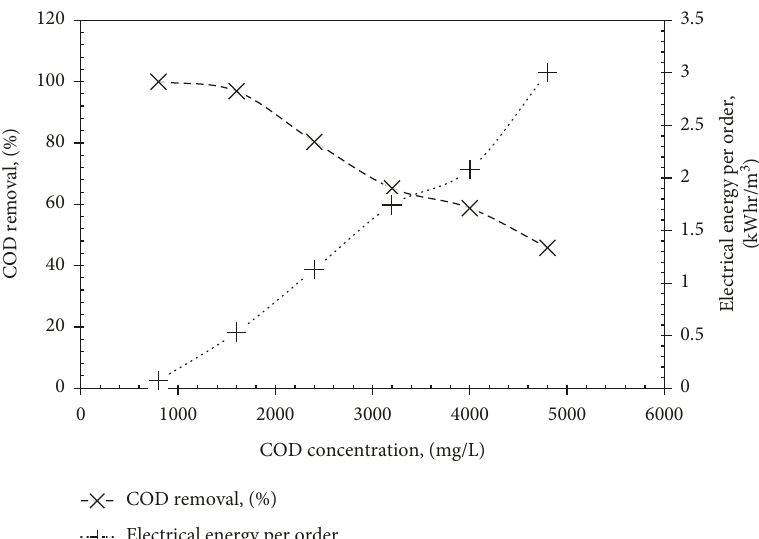
Figure 6: Effect of COD on % COD removal and EE/O in the O rate and production–20 LPM and 4g/h; H 2 O 2 –100mM; Fe 2+ –20mM; and pH–6).